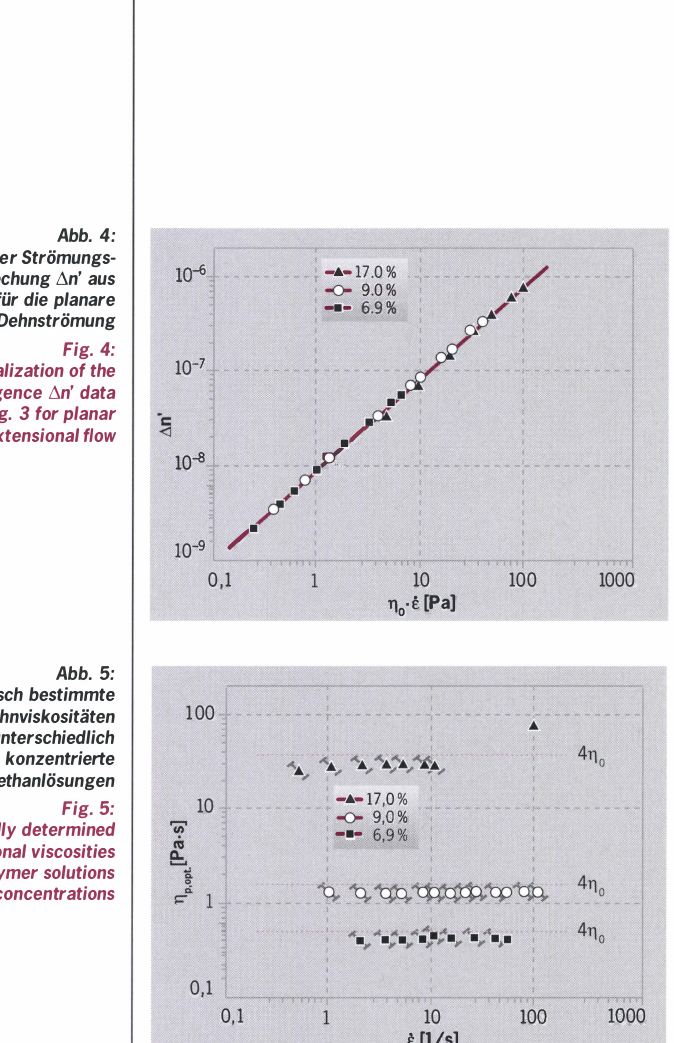
Fig. 4: Normalization of the birefringence t.n' data from Fig. 3 for planar